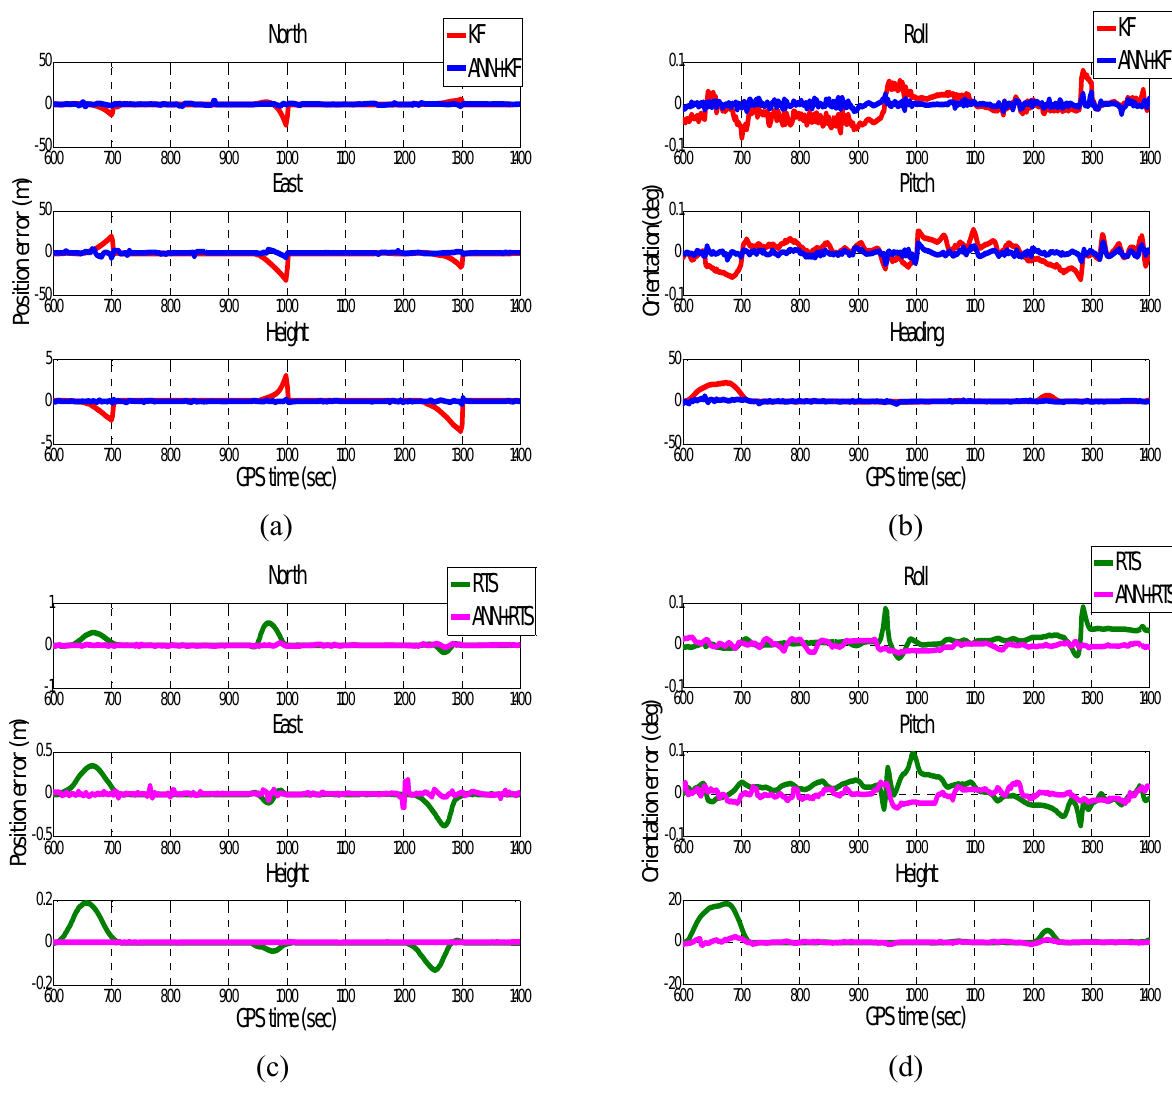
Figure 16. The samples of training results (Trajectory